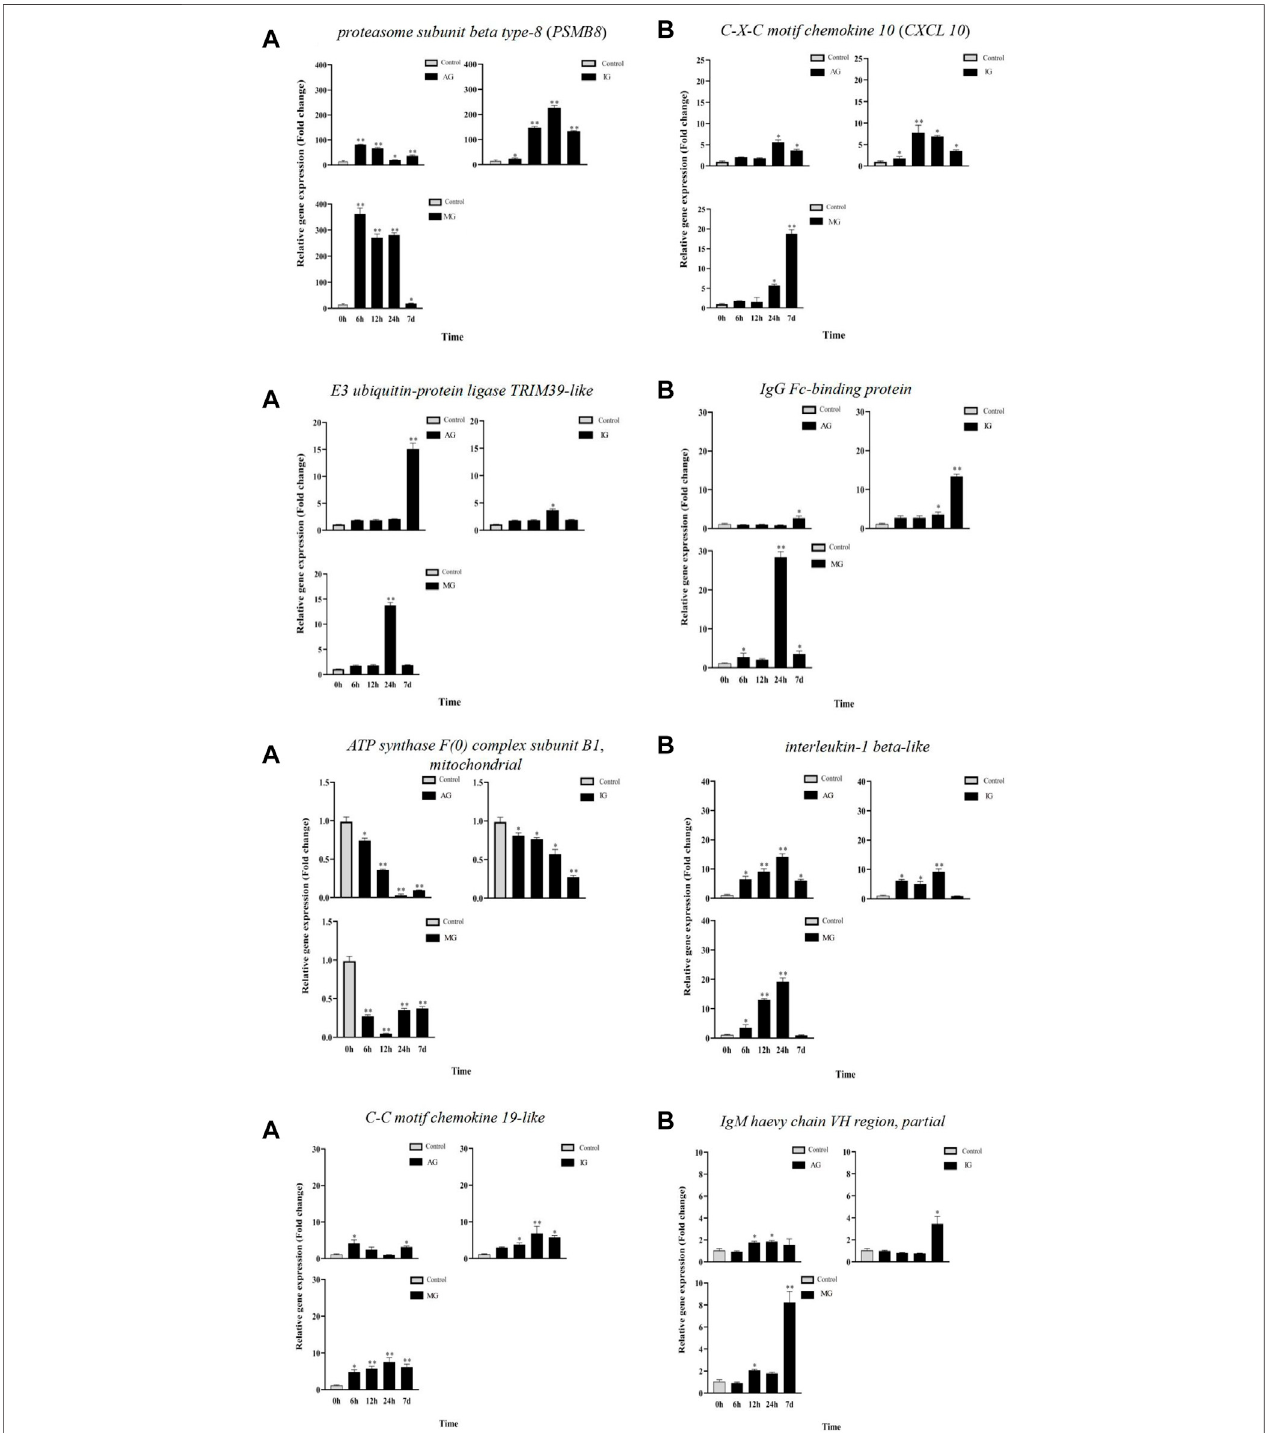
FIGURE 4 | Gene expression analysis from RT-qPCR of Nile tilapia infected with Streptococcus . PSMB8, E3 ubiquitin-protein ligase TRIM39-like, ATP synthase F(0) complex subunit B1, mitochondrial and C-C motif chemokine 19-like gene expression analysisi were shown in (A) . CXCL 10 , IgG Fc-binding protein, interleukin-1 beta-like and IgM haevy chain VH region, partial gene expression analysis were shown in (B) .